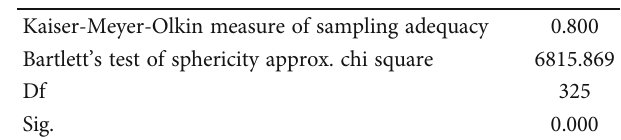
Table 2: Kaiser-Meyer-Olkin adequacy